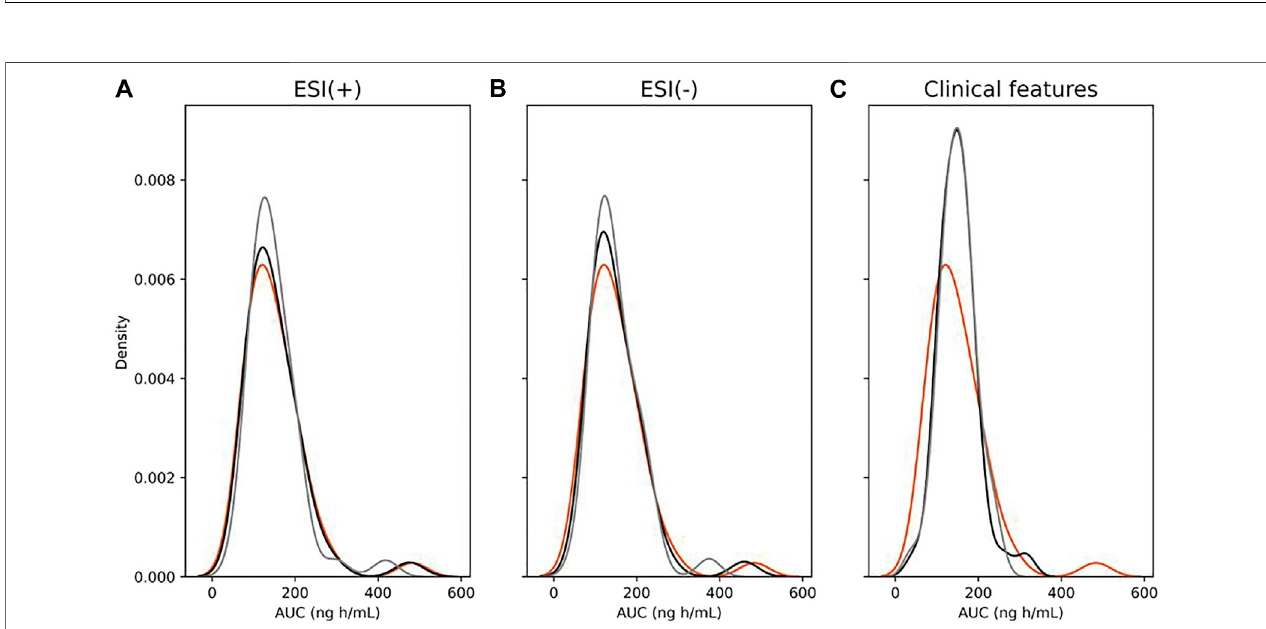
FIGURE 6 | Distribution plots showing the frequency of area under curve (AUC) values of true (orange), training set (black) predicted, and leave-one-out cross- validation (LOOCv) testing (gray) predicted from ESI (+) (A) , ESI ( − ) (B) , and clinical features (C) models.